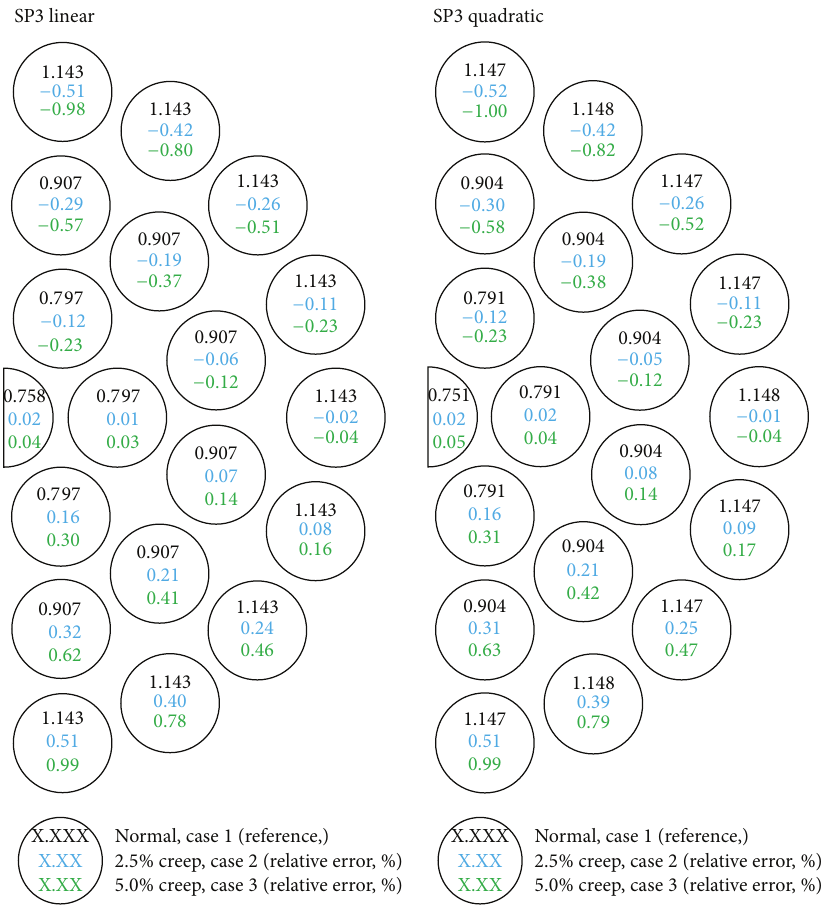
Figure 7: Relative errors of pin power with creep of the TRIAINA-SP3